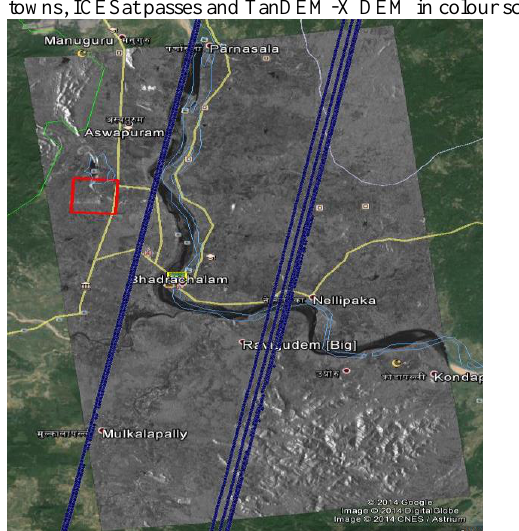
Figure 2. Godavari test area coverage and TanDEM-X amplitude image of Jan 29, 2012 on Google map showing DEM evaluation area in red